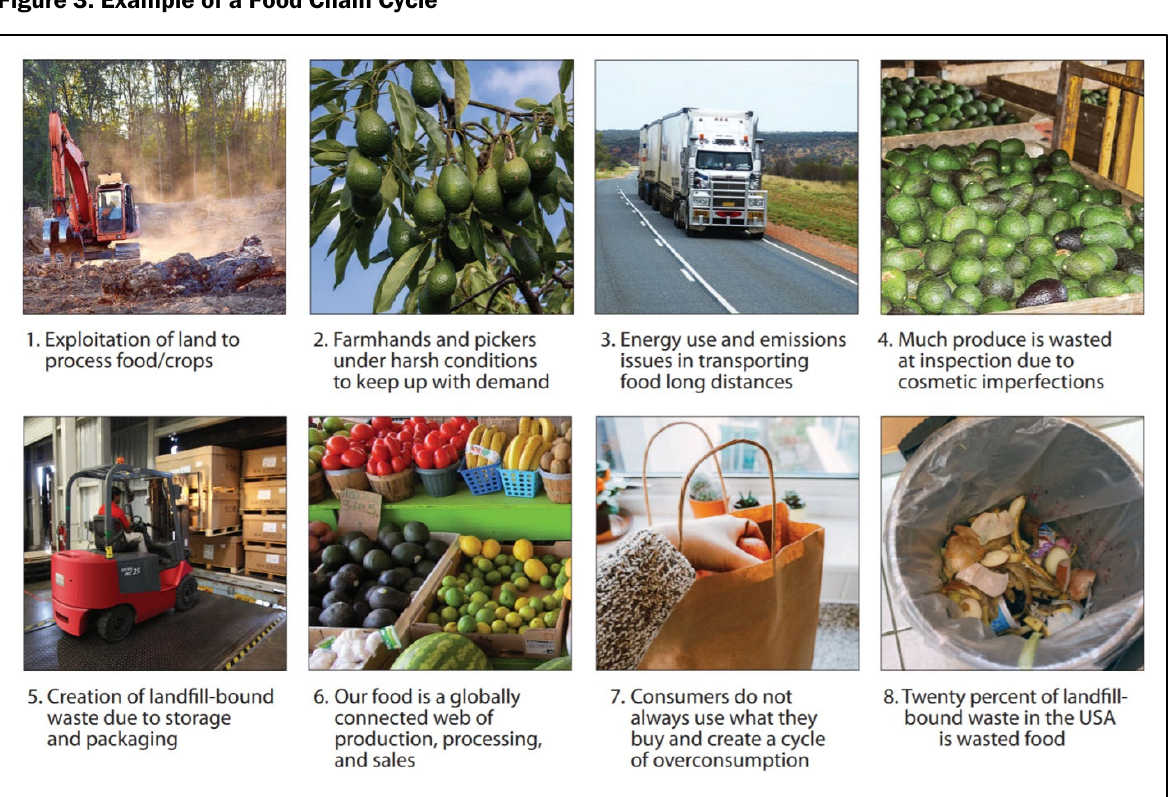
Figure 3. Example of a Food Chain